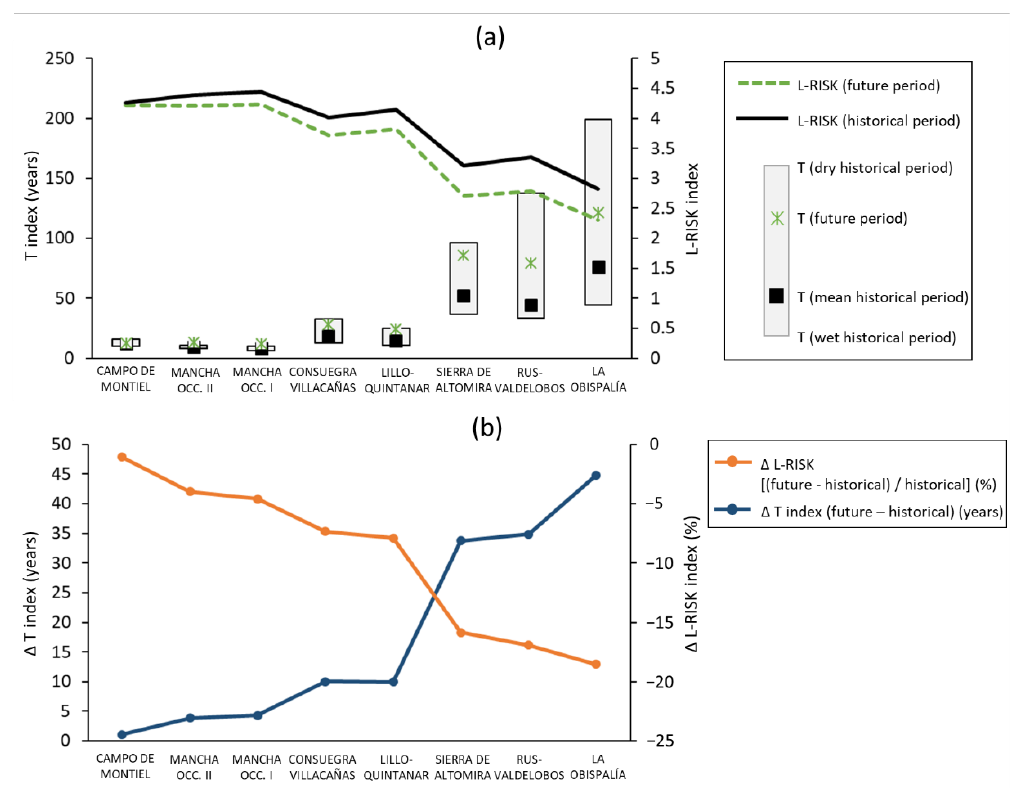
Figure 8. ( a ) Historical (medium, wet, and dry periods) and future T index and historical and future L-RISK for the best linear regression model; ( b ) change between future and historical T (years) and L-RISK (%) indexes.